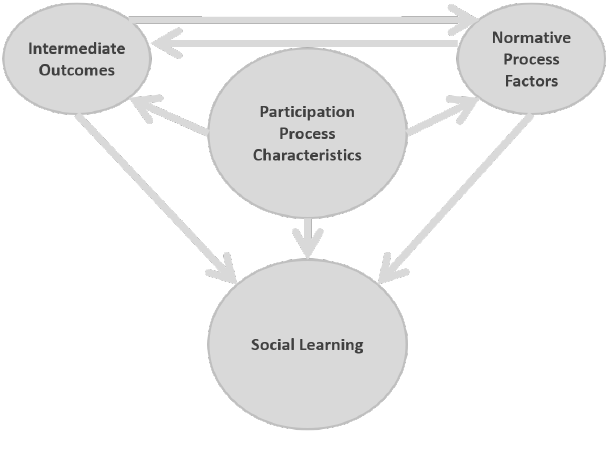
Fig. 1. Interconnections and directions of influence among participation process characteristics, normative process criteria, intermediate outcomes, and social